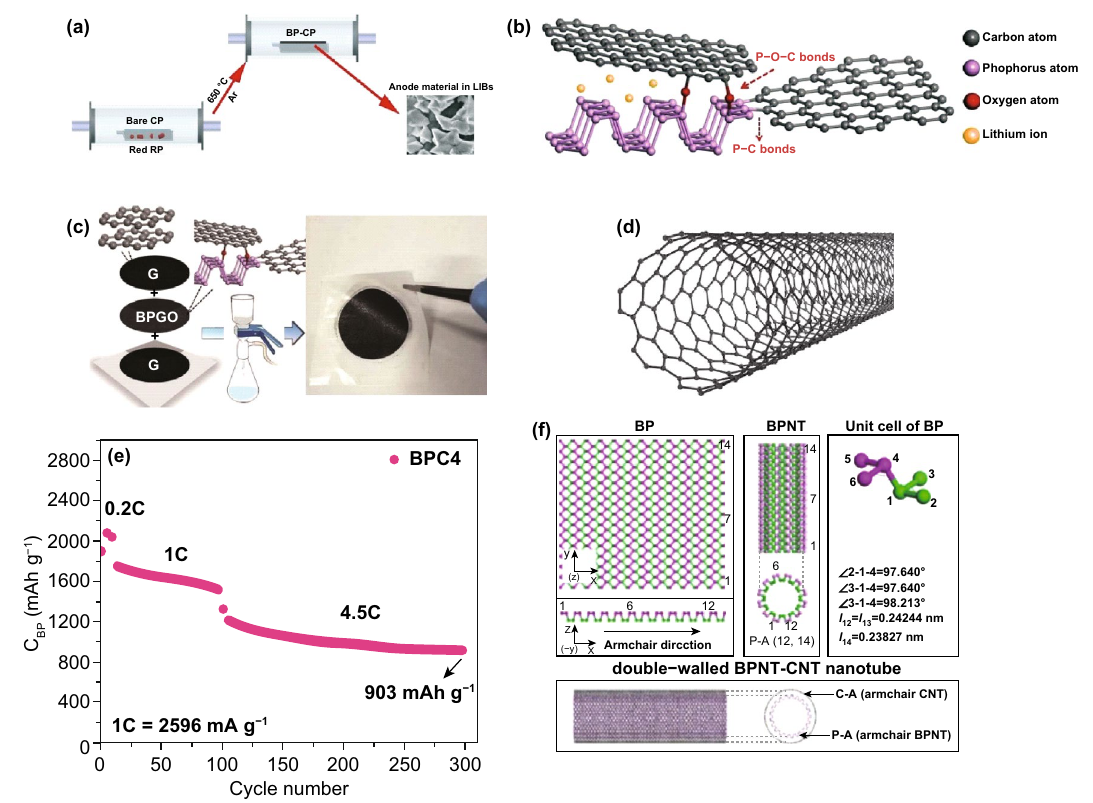
Fig. 8 a The thermal-vaporization deposition process of BP-CP synthesis [73]. b The chemical bonds of BPGO and c G-BPGO-G thin film preparation process [139]. d Atomic structure of CNT. e High-rate cycle stability of BP-CNT at 1C and 4.5C [141]. f The theoretical model of BPNT-CNT double-walled nanotube structure [142]. Adapted from Refs. [73, 139, 141, 142] with